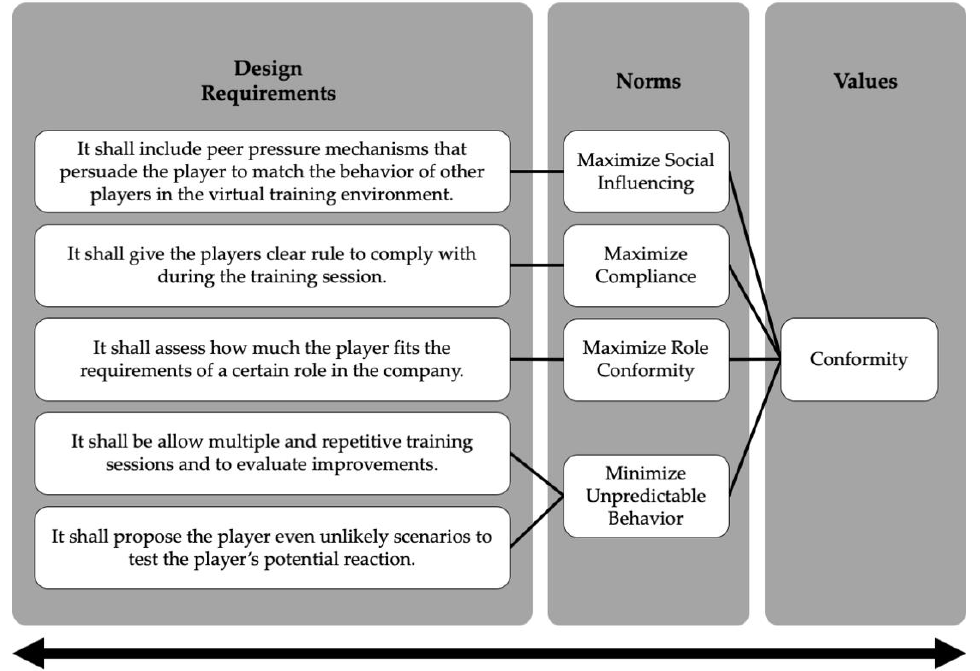
Figure 12. Bi-direction hierarchy showcasing how the value of conformity can be extrapolated from technical design requirements through norms for simulation-based VR training tools.